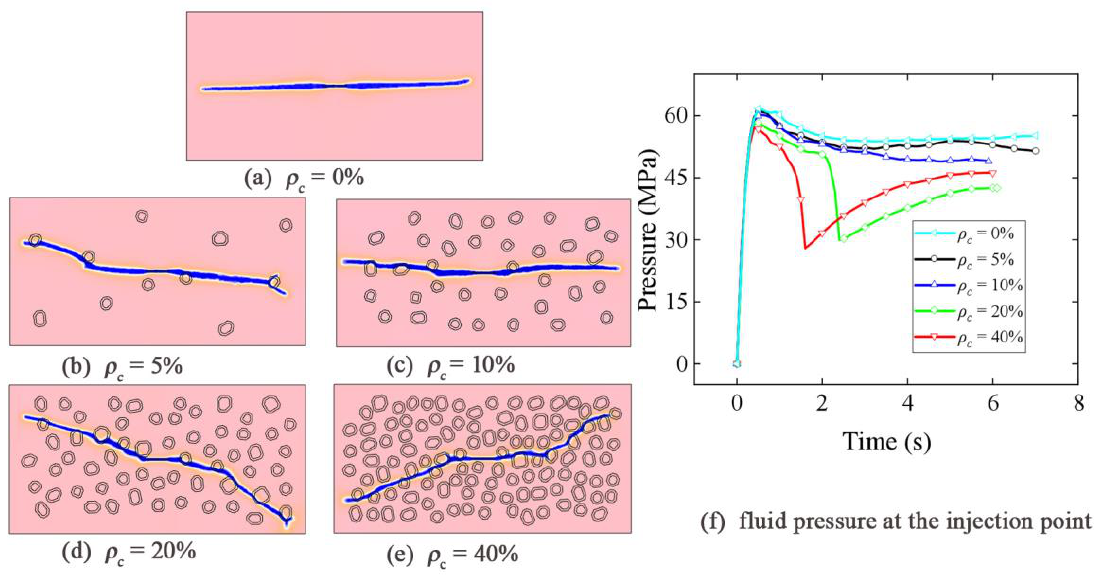
Figure 12. Fracture geometries and fluid pressure at the injection point for different contents ρ of the gravels.